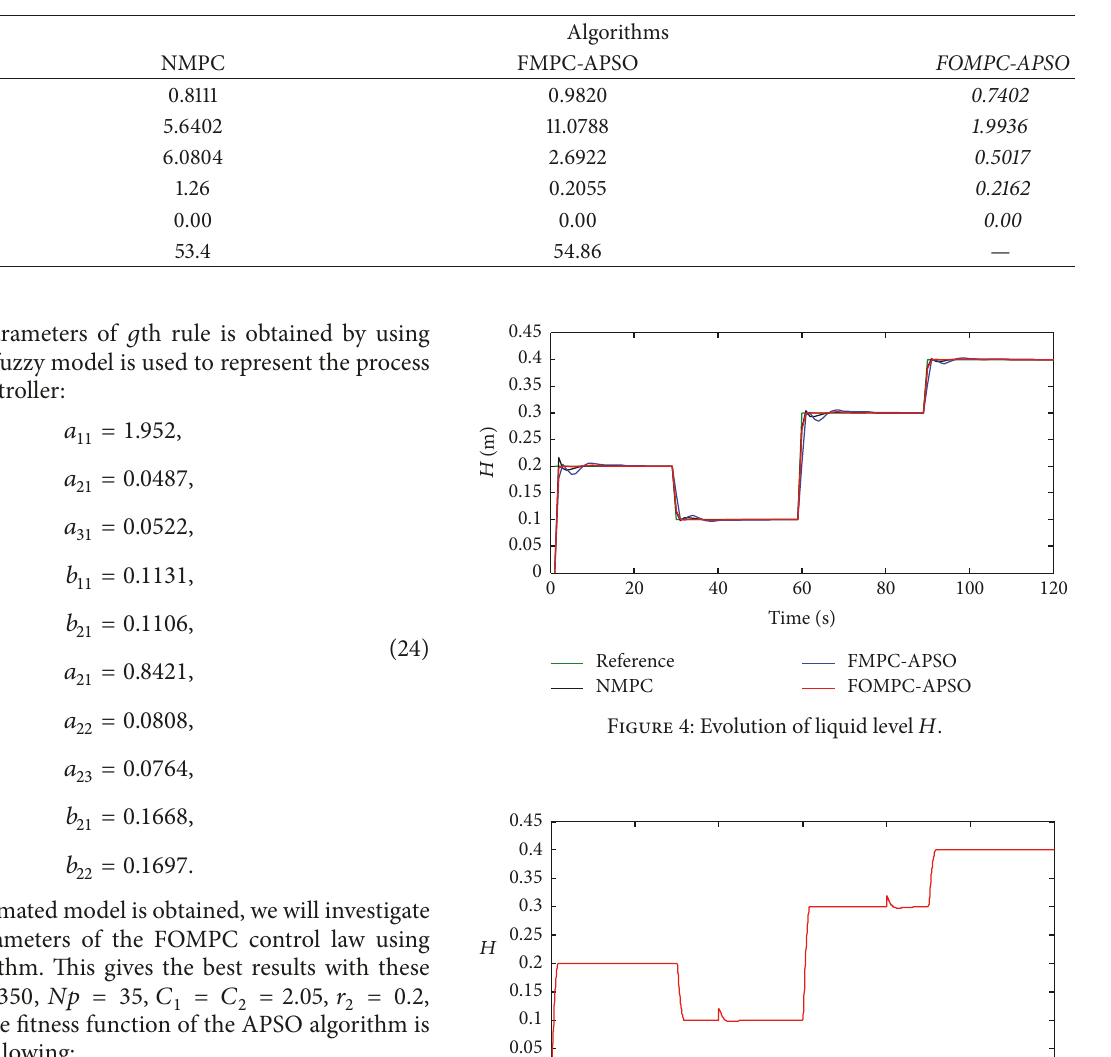
Table 3: Pi performances obtained by the different algorithms.